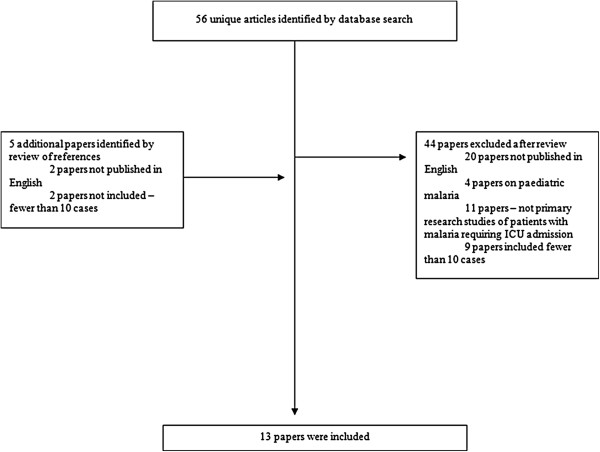
Search strategy.